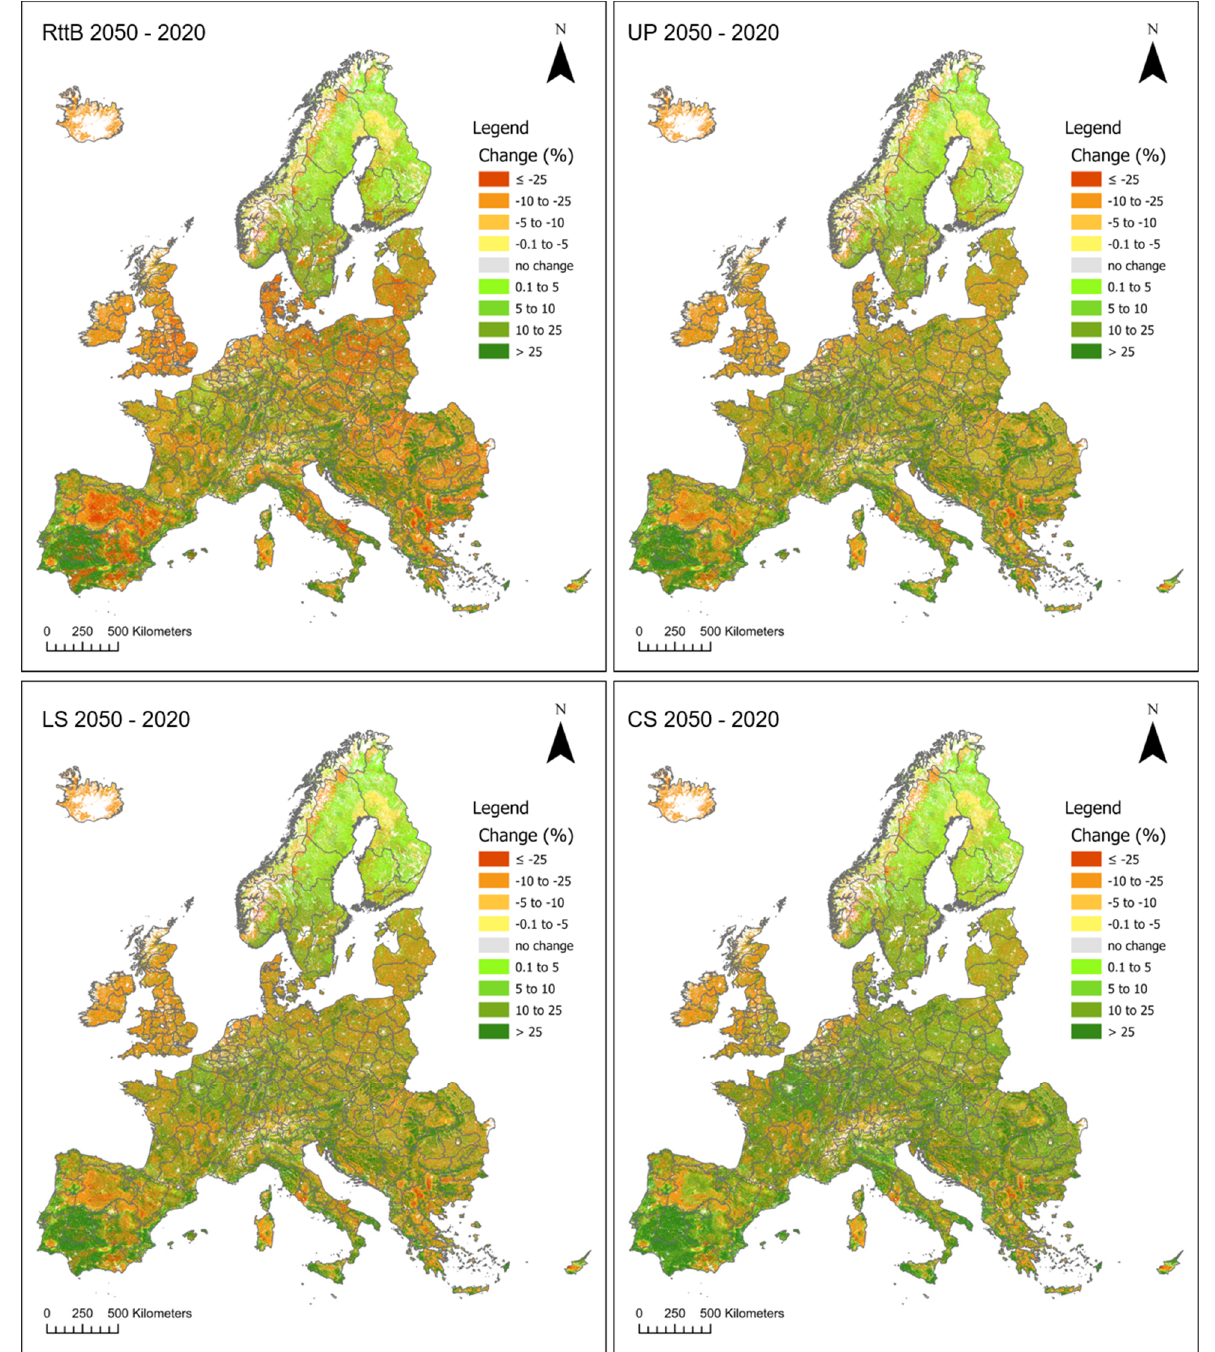
Figure 10. Simulated change in SOC stock (%) between 2020 and 2050 for each scenario.